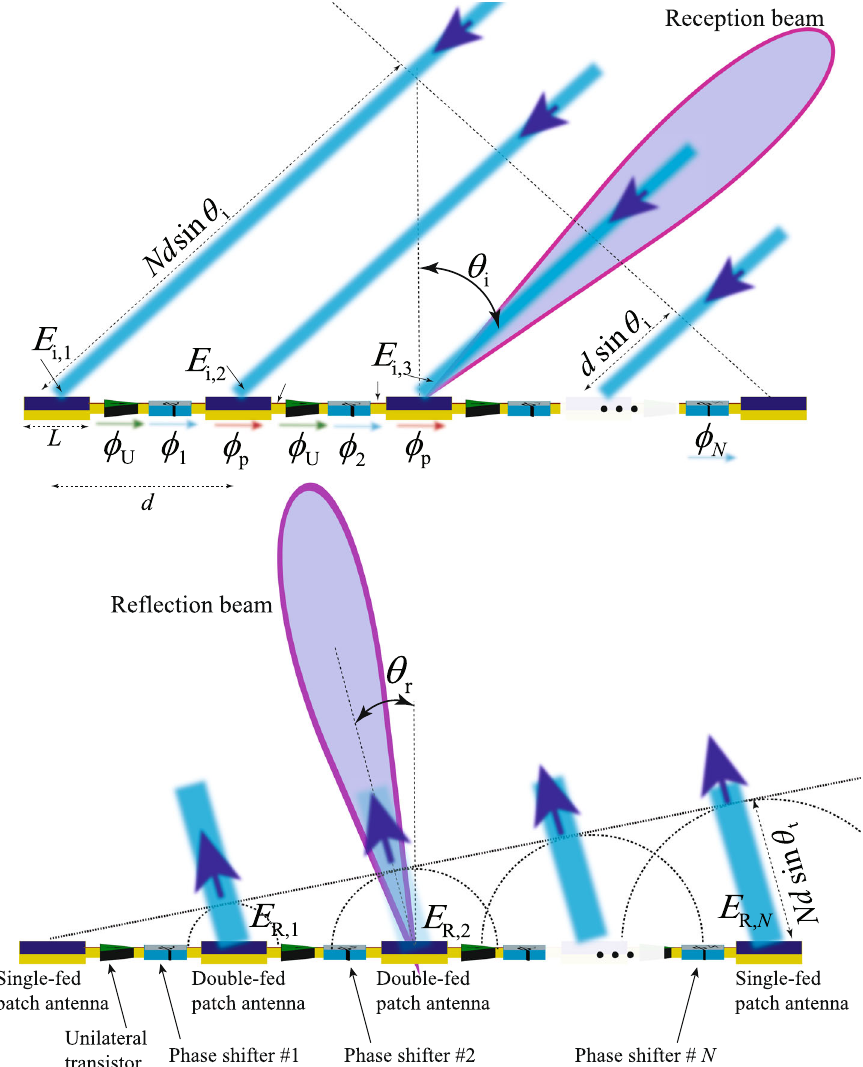
Fig. 3 Beamsteering mechanism of the nonreciprocal re fl ective metasurface. A chain of series cascaded radiating patches are integrated with nonmagnetic nonreciprocal phase shifters, providing an ef fi cient mechanism for wave reception, one-way signal ampli fi cation, nonmagnetic nonreciprocal phase shifting, and steerable wave re fl